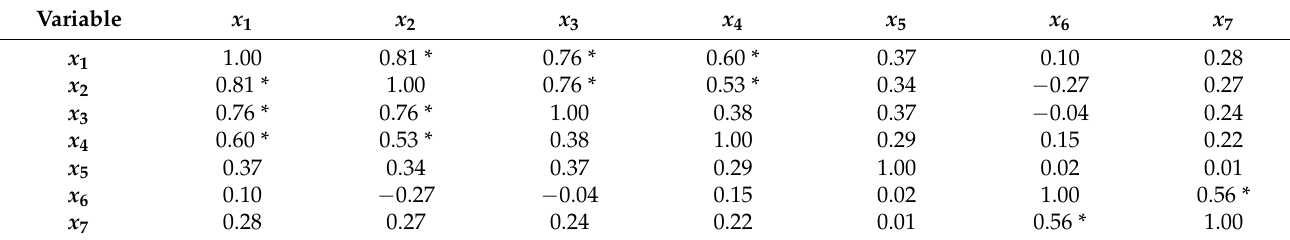
Table 1. A Pearson correlation matrix for the investigated